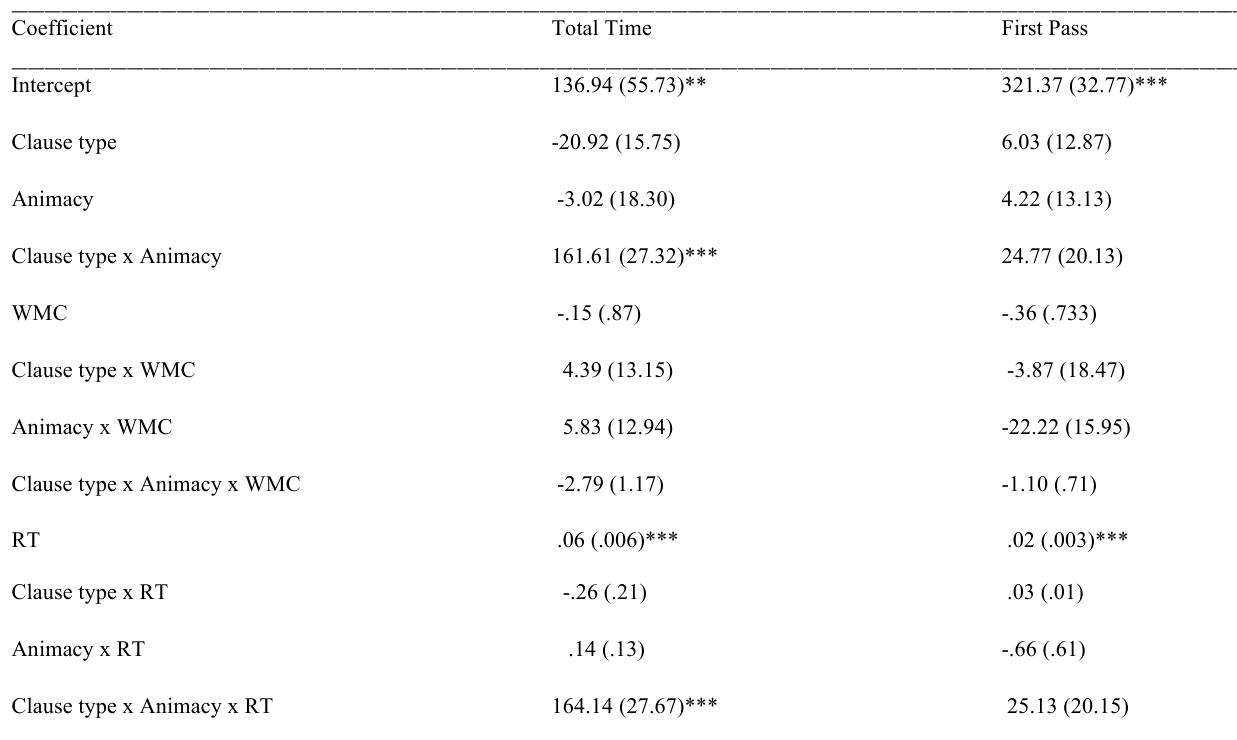
Hierarchical Linear Model – Model Estimates for Main Verb